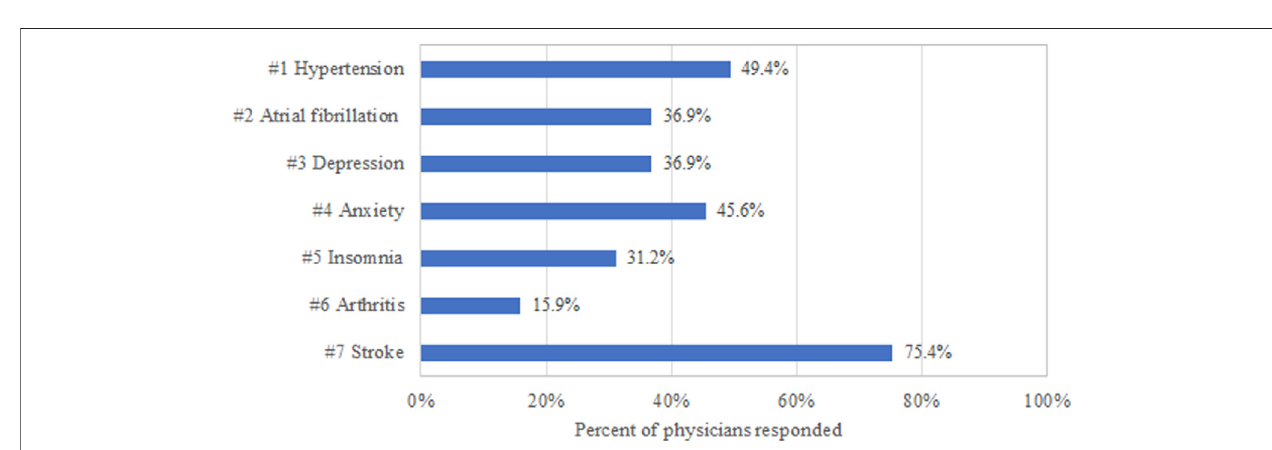
Frontiers in Pharmacology |